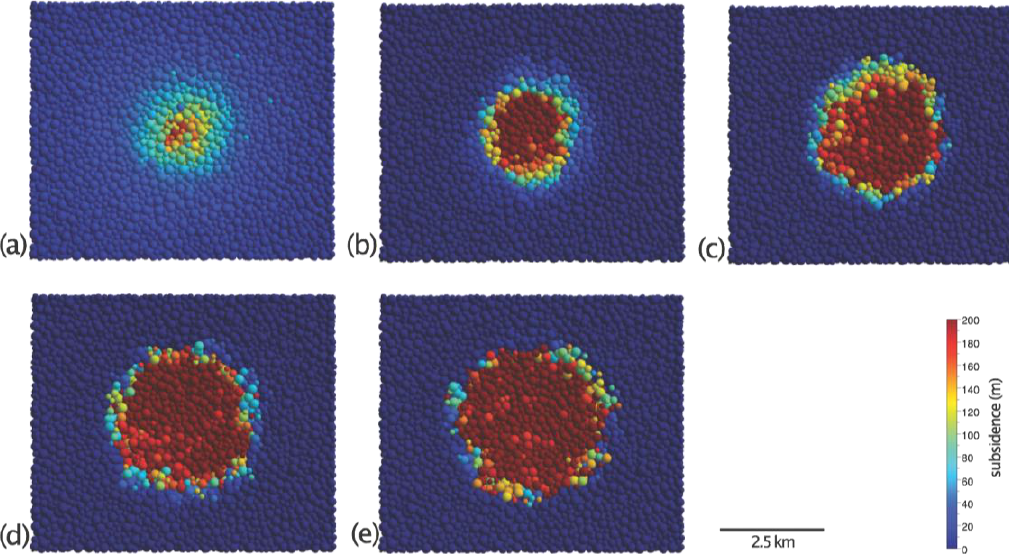
Figure 4. Evolution of (incremental) caldera surface subsidence accrued during the preceding 200 m of basal subsidence at ( a ) 200, ( b ) 400, ( c ) 600, ( d ) 800, and ( e ) 1000 m basal subsidence for an experiment with a piston with a flat, circular roof.